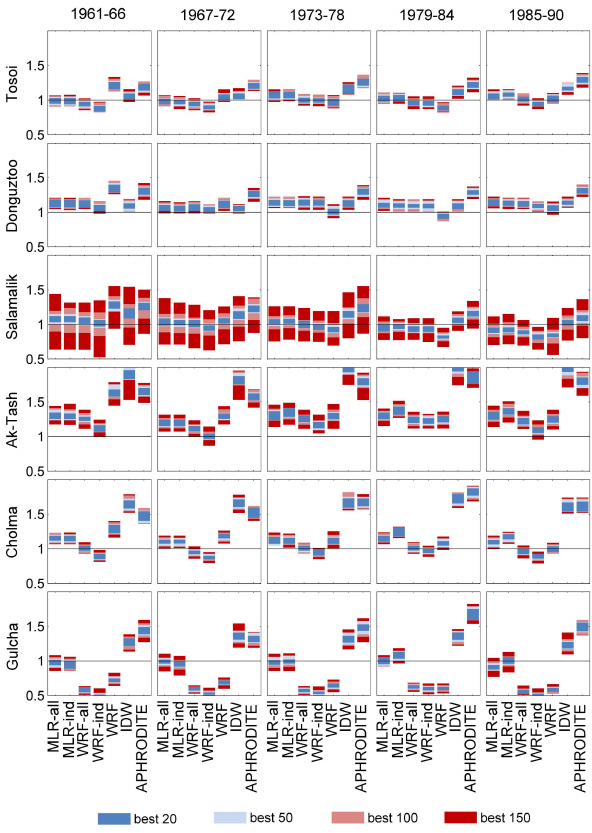
Fig. 10. Variation of the precipitation bias factor for different precipitation data sets (bars in each plot), different time periods (columns), and different subcatchments (rows). The colours indi- cate the range of the precipitation bias factor for the best 20, 50, 100 and 150 parameter